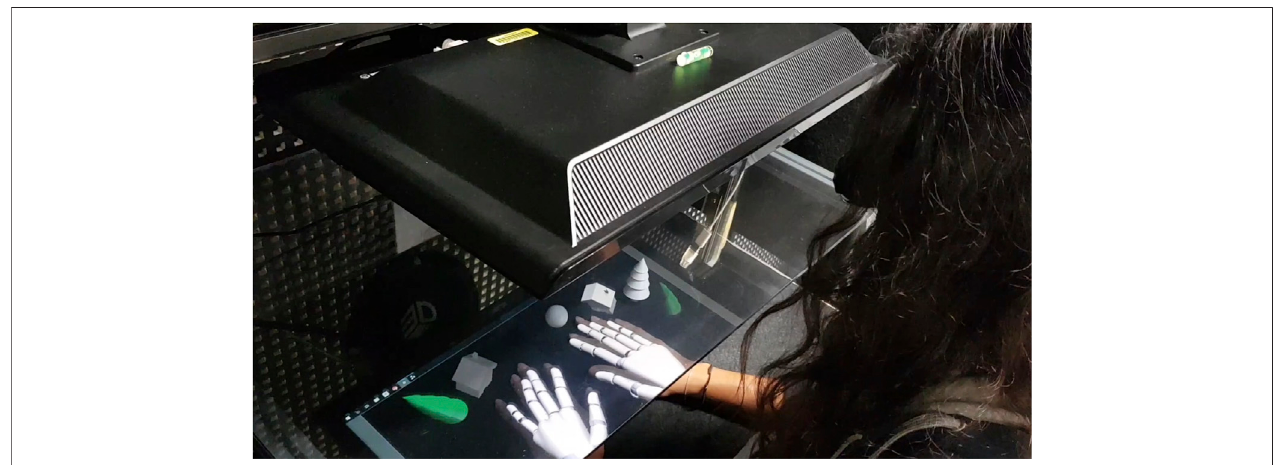
FIGURE 1 | The experimental setup. A user equipped with tracked shutter glasses looks at her virtual hands under the semi-transparent mirror. The rendered perspective of the holograms is adapted to her point of view in real-time. For illustration clarity, we colored two of the virtual trees in a distinct color (green) from the real objects (white). All objects were white during the